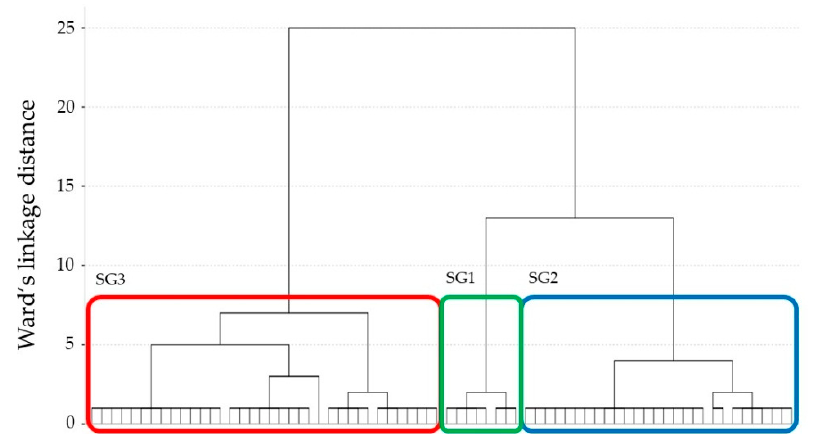
Figure 2. Dendrogram of the hierarchical cluster analysis. Linkage distance on the y -axis and individual patients on the x -axis. The three identified SGs (subgroups 1–3) are identified by a colored square.